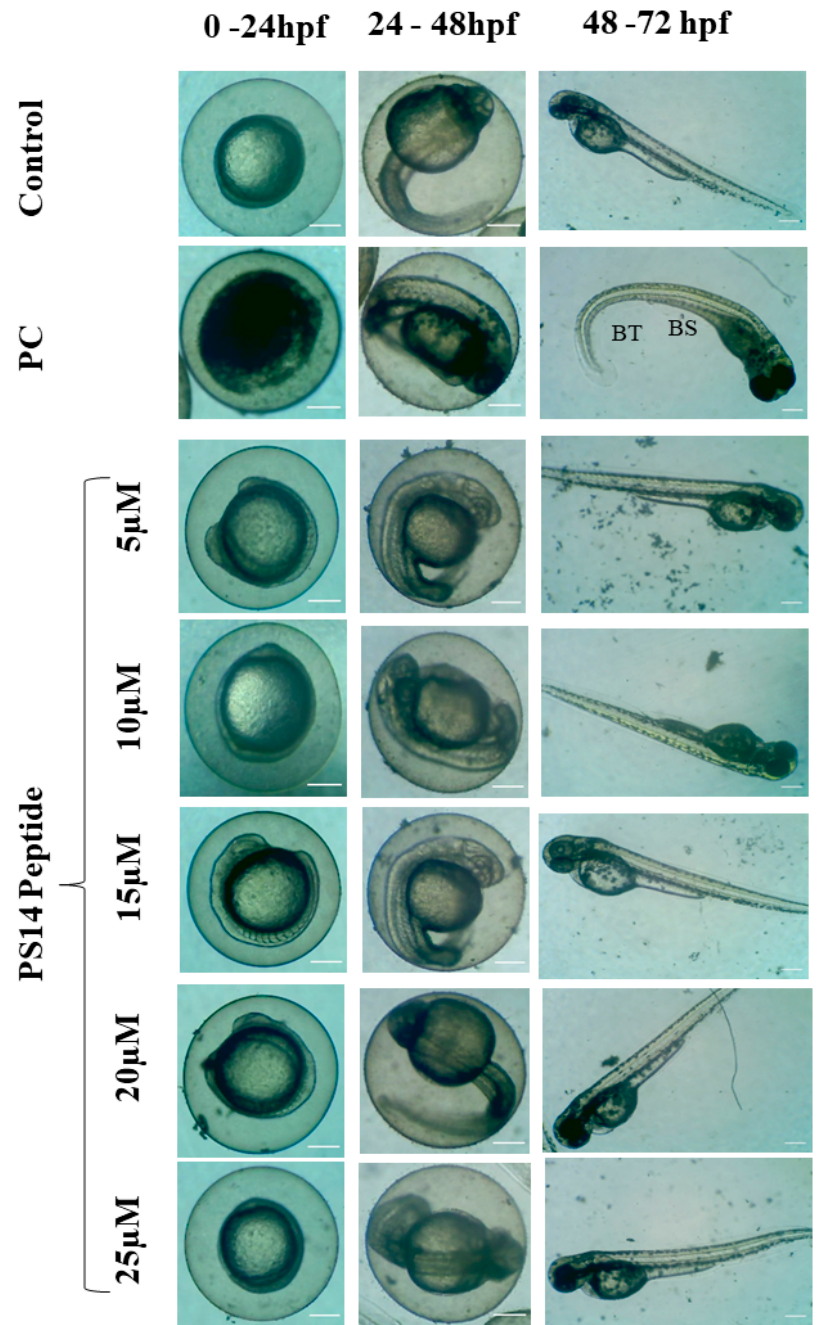
Figure 2. Developmental toxicity on zebrafish larvae observed between 0 hpf and 72 hpf. The larvae were treated with five different concentrations of PS14 along with an untreated control and positive control (PC) 1 mM of H 2 O 2 . PC showed abnormal morphologies such as bent spine (BS) and bent tail (BT).